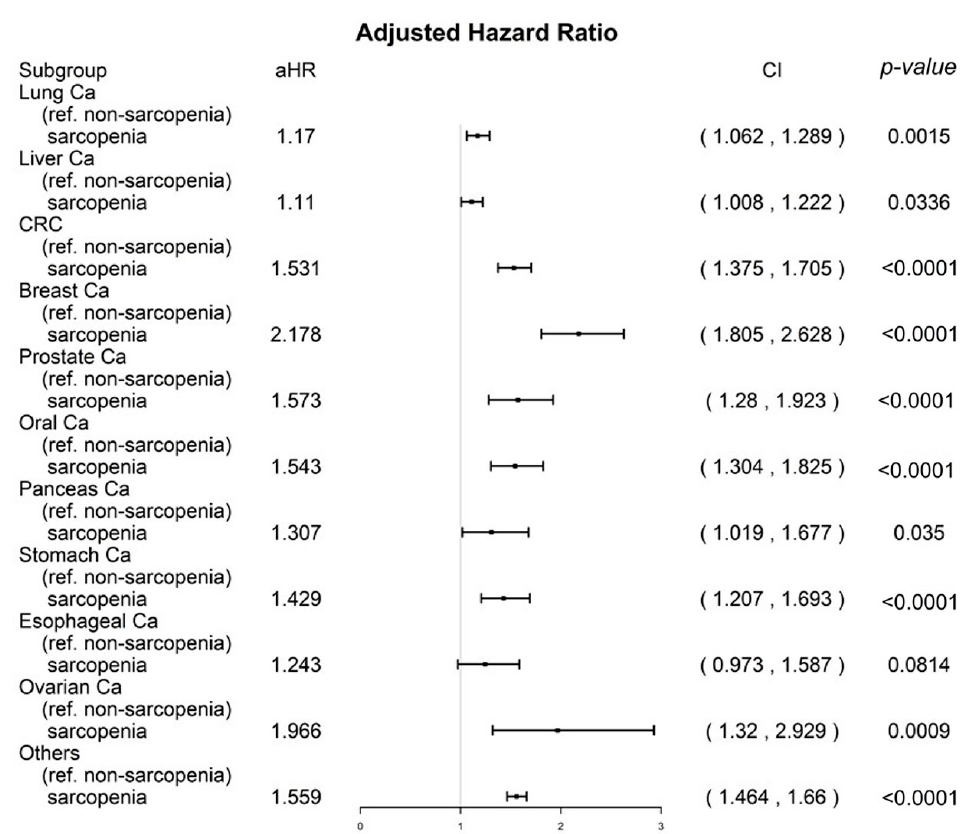
Figure 1. A sensitivity analysis of different cancer types by using inverse probability of treatment weighting for all-cause death in the propensity score–matched sarcopenia and nonsarcopenia groups. All covariates presented in Table 2 were